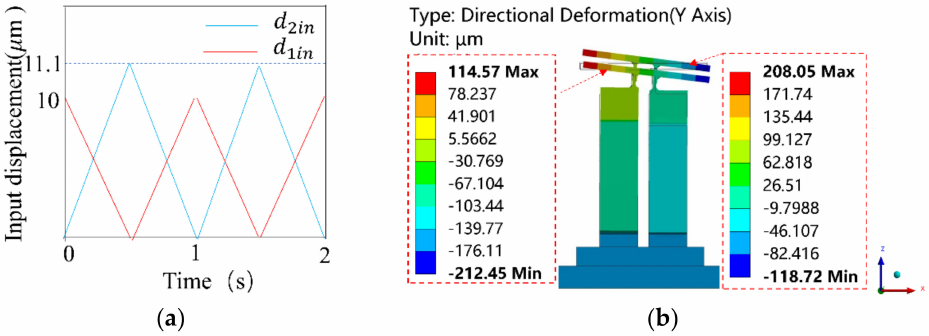
Figure 9. ( a ) Translation displacement input signal. ( b ) Dual-drive translation.